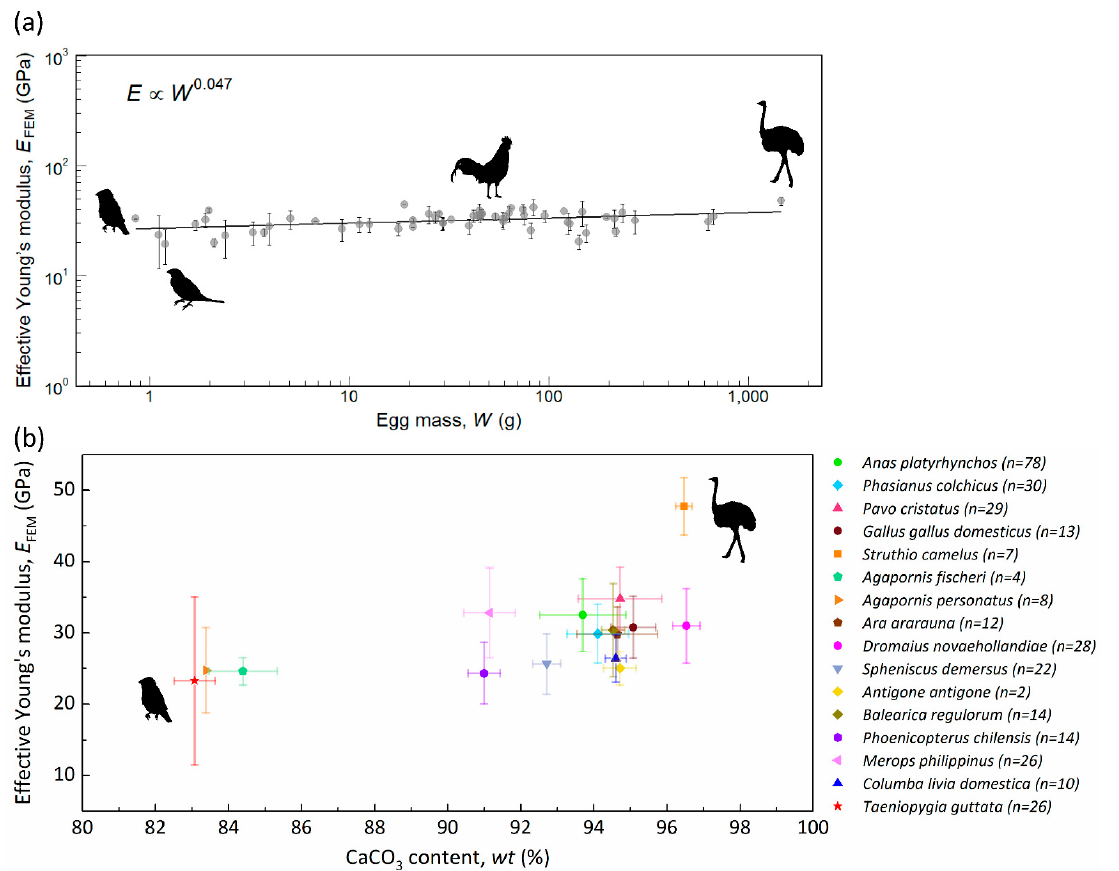
Figure 2. ( a ) Effective Young’s modulus, E FEM . One point represents one avian species, and the error bars are the intraspecific standard deviations. The silhouettes from left to right are zebra finch ( Taeniopygia guttata ), society finch ( Lonchura striata domestica ), domestic chicken ( Gallus gallus domesticus ), and ostrich ( Struthio camelus ). ( b ) The relation between the effective Young’s modulus and the weight percentage of CaCO 3 , and the error bars are the standard deviations. The number, n , is the specimen amount calculated for the effective Young’s modulus.